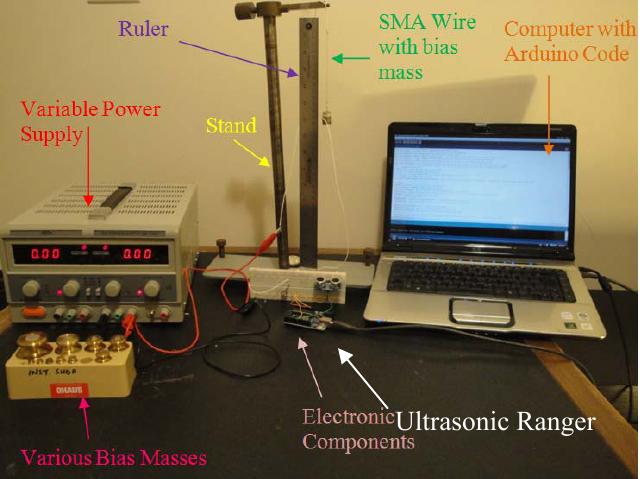
Figure 2. The labelled testing apparatus for the SMA helical spring